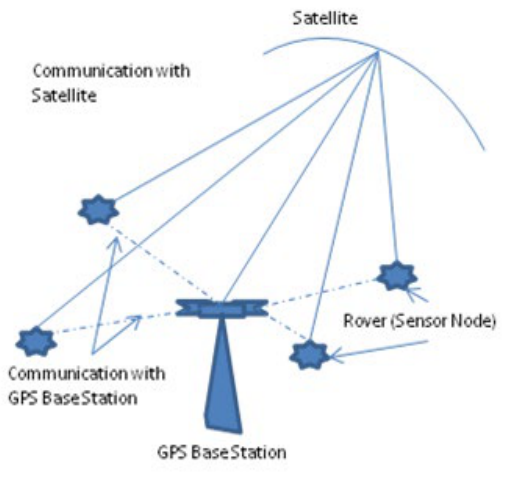
Figure 4. Real-Time Kinematic (RTK) setup [8] [9] [10] The GPS base station is placed in a location where there are at least, four or more GPS satellites that are in sight. The distance is calculated by a satellite and communicated with the rovers. At the same time, the rover’s receiver gets the measurements from the satellites and processes them with the BS information. It calculates their location relative to the base station. The accuracy of GPS based RTK is up to 2 centimetres. This technique can be used in the localization of sensor nodes and routing in WSN [11].